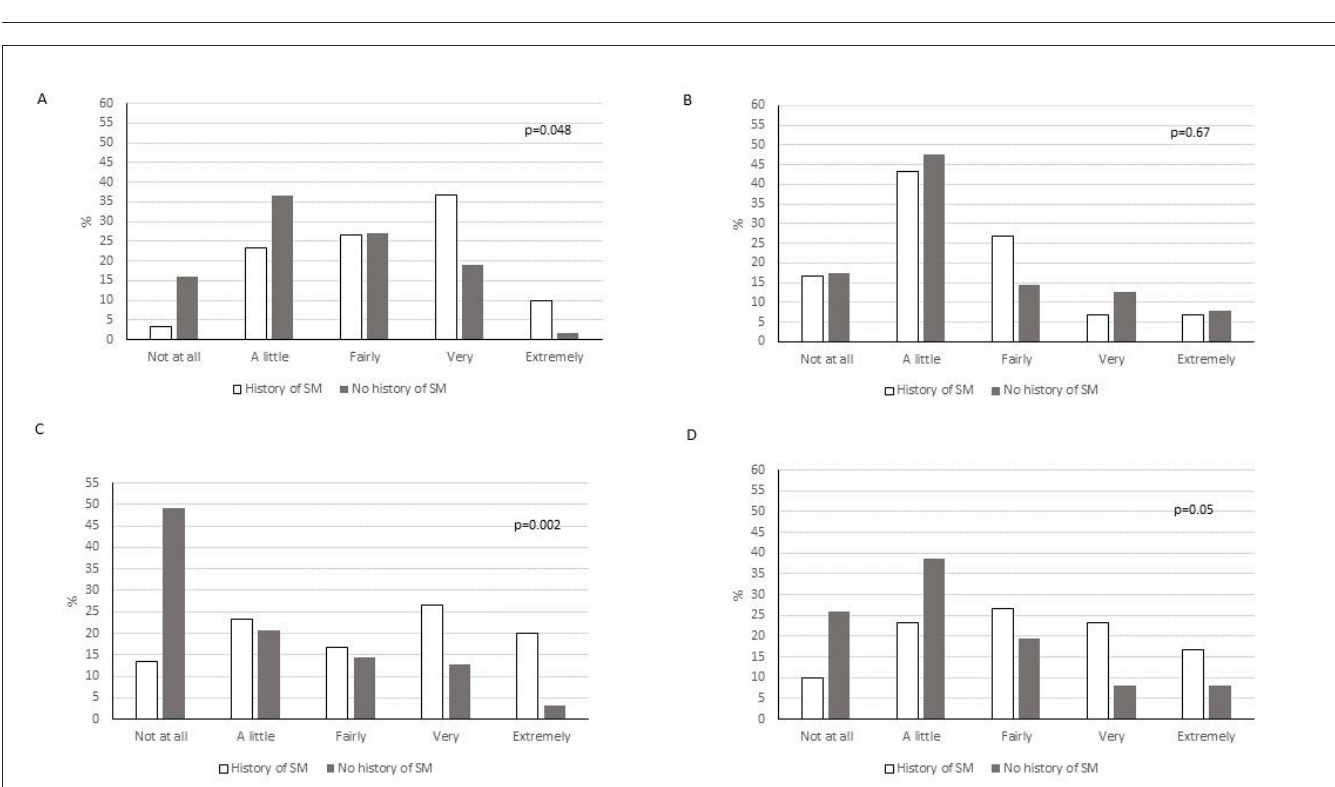
Figure 1 Responses of pregnant women (in the first trimester) on the four items constituting the dimension 'medical and obstetric risks or fetal health' of the Antenatal Perceived Stress Inventory, according to the presence or absence of prior spontaneous